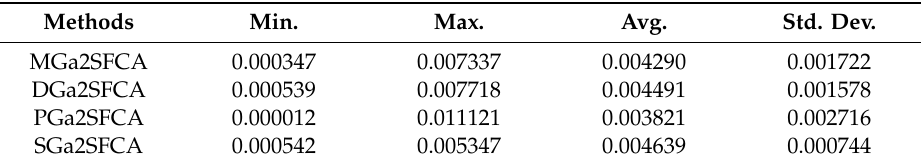
Table 2. Statistics of accessibility, calculated using 4